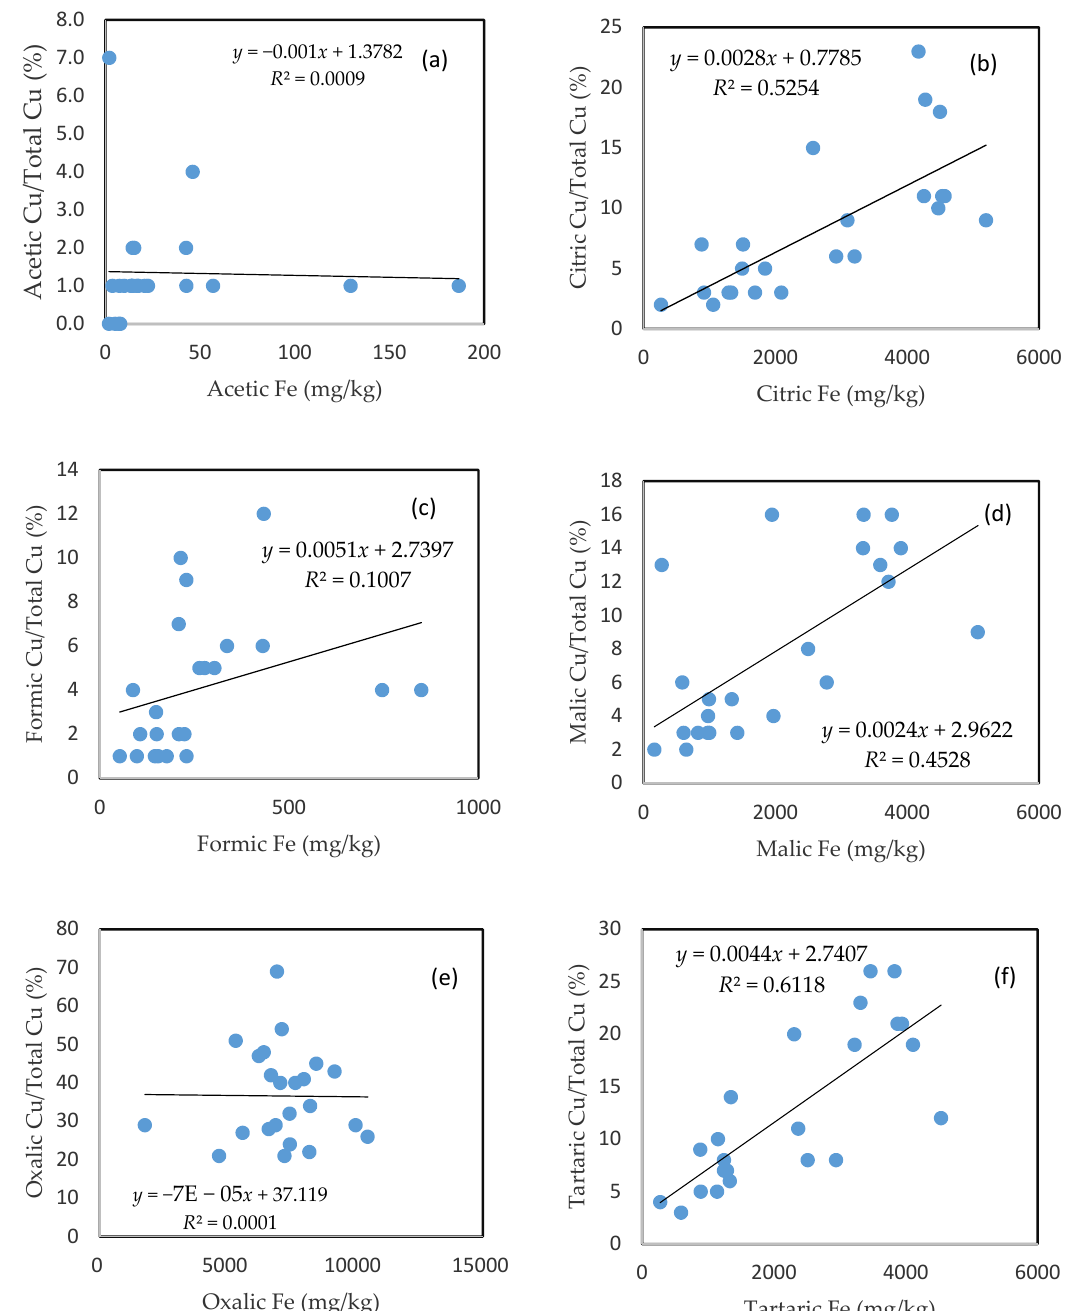
Figure 3. Relationship between the amount of Fe released from the soil and the rate of Cu mobilization in ( a ) acetic acid, ( b ) citric acid, ( c ) formic acid, ( d ) malic acid, ( e ) oxalic acid, and ( f ) tartaric acid treatments.